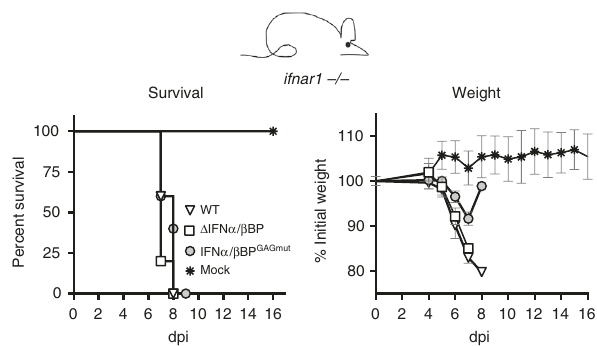
Fig. 5 Infection of mice lacking IFNAR1. Mice de fi cient in IFN-I cellular receptor ( ifnar1 − / − ) were s.c. inoculated in the footpad with 100 pfu of WT or the indicated mutant ECTV, and monitored daily for survival and weight loss. Mean±SD data corresponding to one experiment with fi ve mice per group